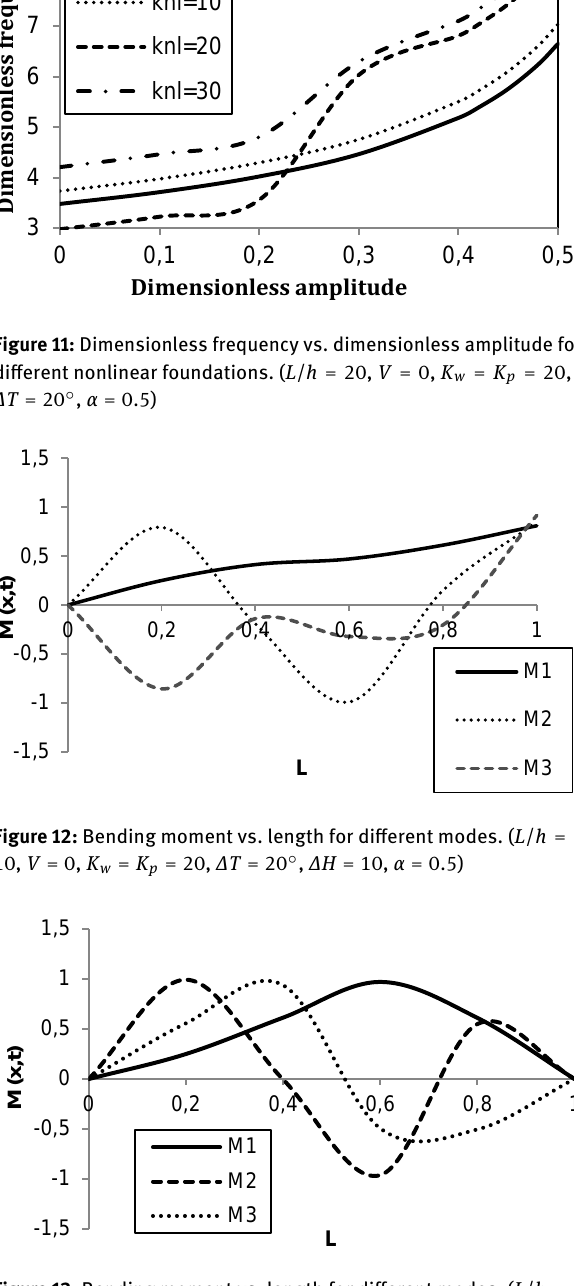
Figure 13: Bending moment vs. length for different modes. ( L / h = 10 , V = 0 , K w = K p = 20 , ∆T = 20 ∘ , ∆H = 20 , α = 0.5